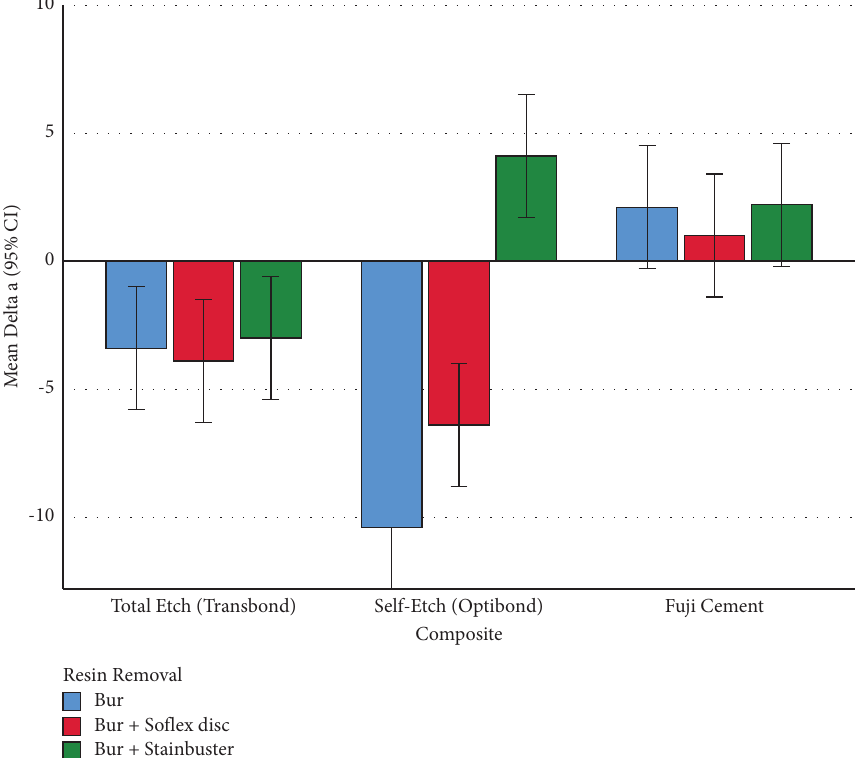
Figure 2: Means (and 95% CIs) for the Δ a parameter in all the 9 groups ( n � 9 × 10). Positive values indicate shades of red, while negative values indicate shades of green.